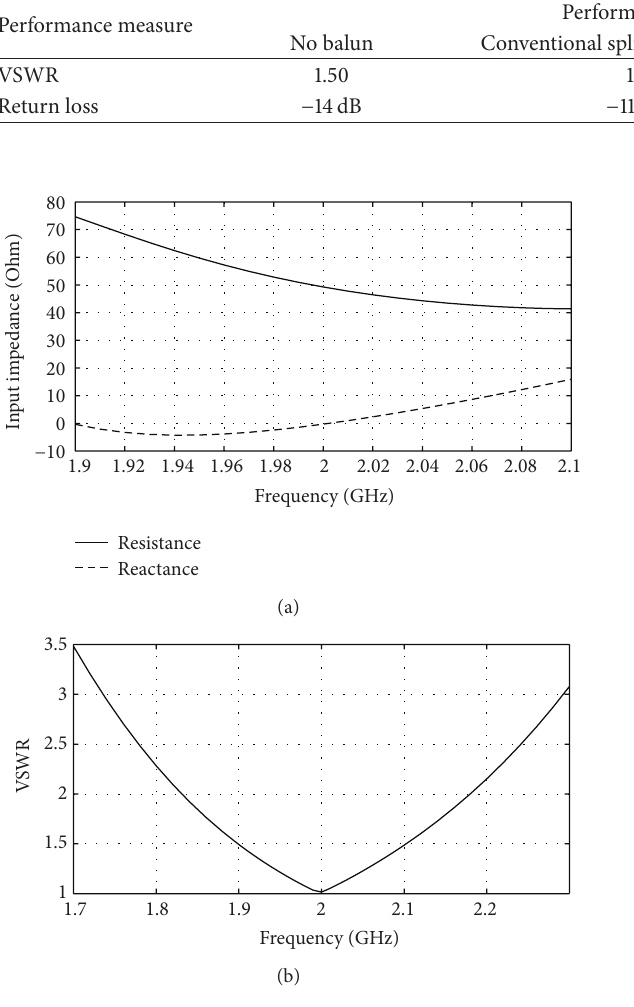
Figure 18: Variation of (a) the input impedance and (b) VSWR of a split coaxial balun feeding a bowtie antenna with the frequency = 8 mm, 𝐷 for a 50 Ω -source; 𝐷 out = 6.72 cm, 𝐿 = 3.44 cm, 𝐿 𝐿 1 out 2 out = 3.8 mm, 𝜃 = 35 ∘ . Bowtie dimensions: 𝐿 𝐿 𝑡 𝑠 = 45 ∘ . 4.5 mm, and 𝜃 𝑓